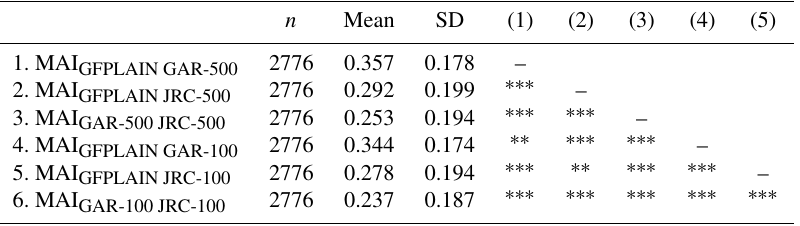
Table A3. Summary statistics and pairwise comparisons of the model agreement between each pair of flood maps. A Kruskal–Wallis test showed that there is a significant difference in model agreement between groups ( H( 5 ) = 1217, p < 0 . 001). The pairwise comparisons, for detecting significant differences between the groups, have been conducted using the Wilcoxon rank-sum test with continuity correction.